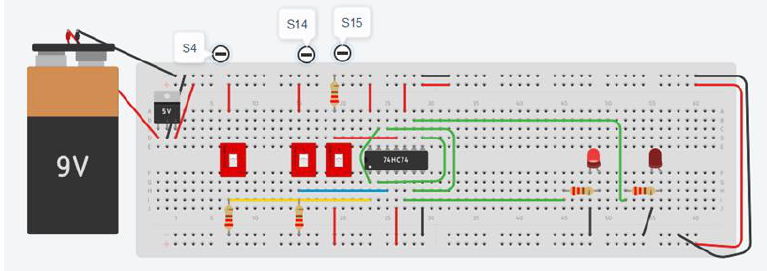
Figure 7. Result circuit